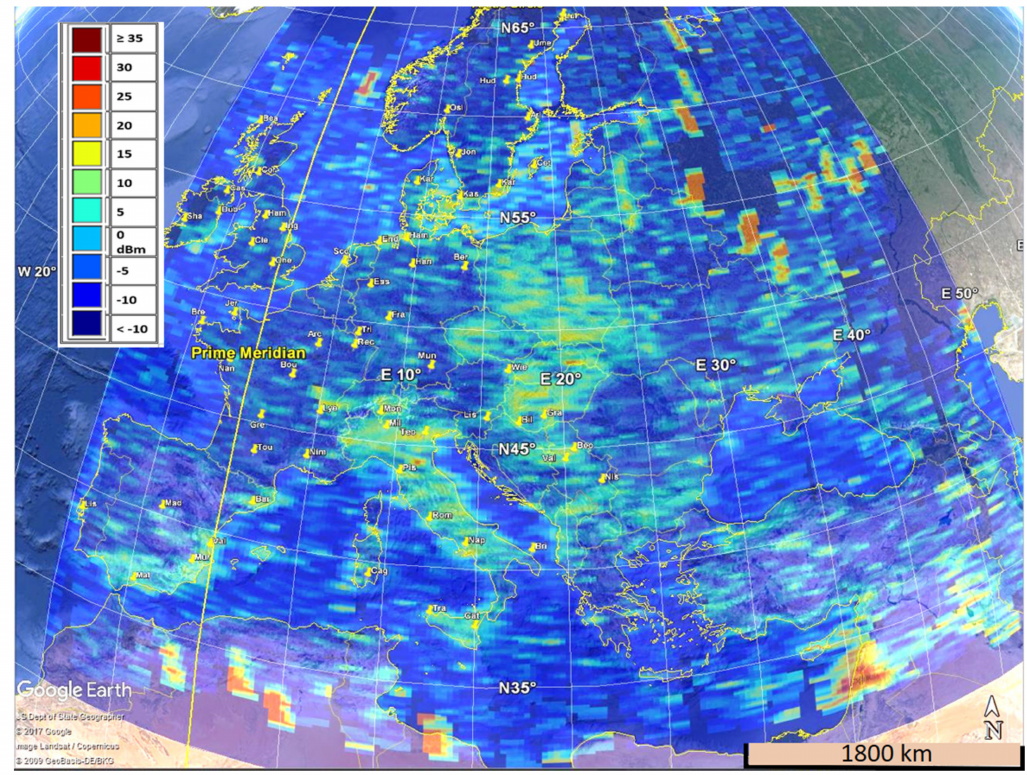
Figure 10. Map of RFI power, averaged in approximately 6 ms. The label superposed marks a part of weather Radar listed in